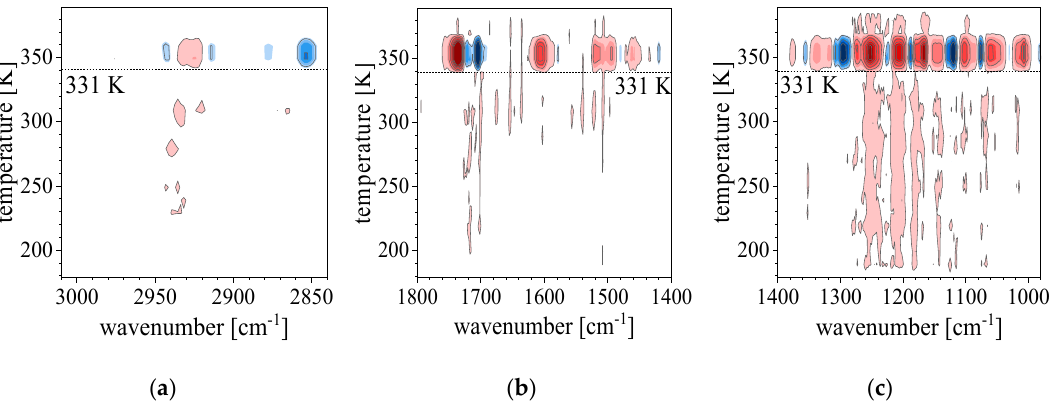
Figure A2. PCMW2D correlation synchronous maps in the heating mode of 3F7HPhH7 in the wavenumber regions of: ( a ) 3100–2800 cm –1 , ( b ) 1800–1400 cm –1 and ( c ) 1400–1000 cm –1 . The red or blue areas represent positive or negative correlation intensities, respectively.